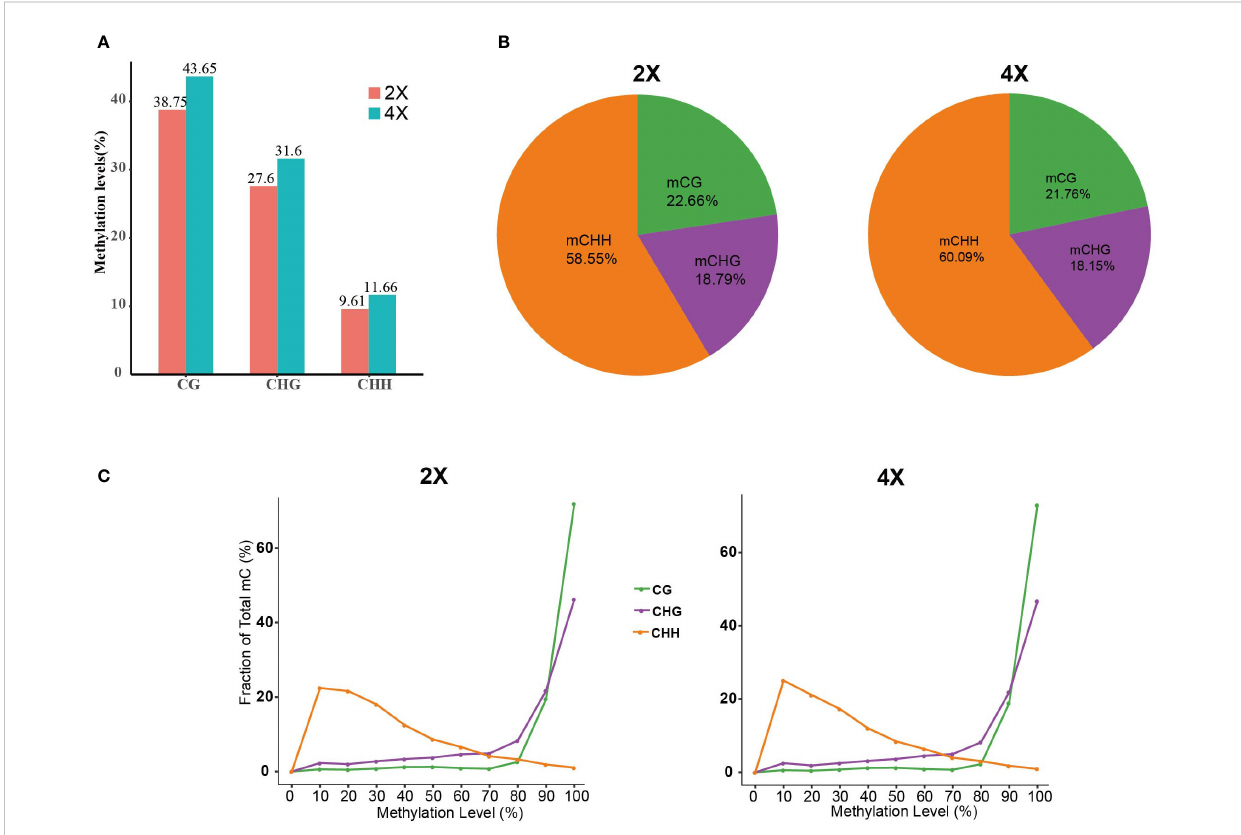
FIGURE 5 The distribution of methylated C sites. (A) Methylation levels in different contexts. (B) Map of the proportional distribution of methylated C sites. (C) Map of methylation site level